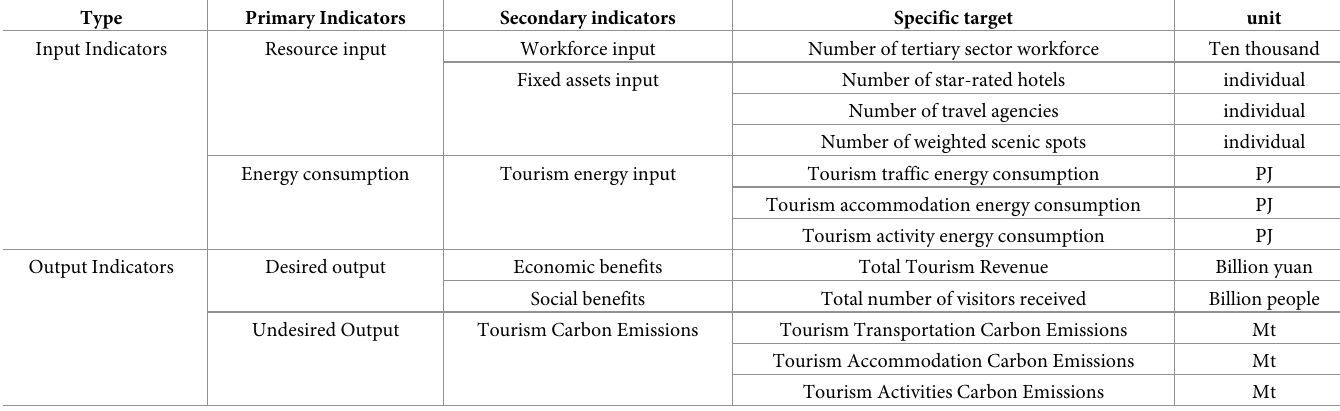
Table 1. Evaluation index system of provincial tourism ecological efficiency in